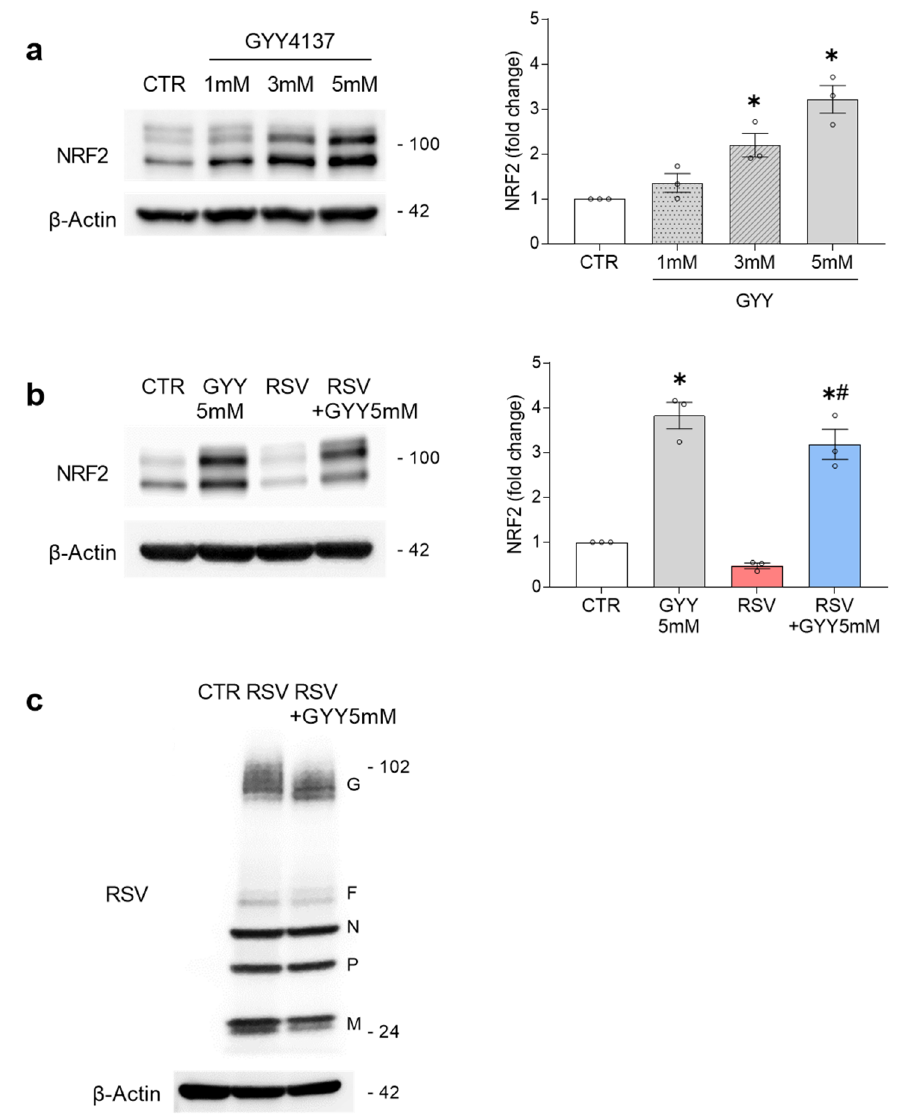
Figure 1. H 2 S donor GYY4137 activates and rescues NRF2 in RSV infection. ( a ) Primary human small airway epithelial cells (SAECs) were treated with 1, 3, or 5 mM GYY4137 or its vehicle. Cells were harvested 17 h after treatment and total cell lysates were analyzed by Western blot with anti-NRF2 antibody. The membrane was reprobed with anti- β -actin antibody for loading control. Western blot image is one representative of three independent experiments. The graph shows the densitometric analysis of NRF2 after normalization to β -actin expressed as mean ± SEM. Data were analyzed by one-way ANOVA followed by Tukey’s test (* p < 0.05 vs. CTR); ( b ) SAECs uninfected and infected with RSV were treated with 5 mM GYY4137 (or vehicle). GYY4137 was added 1 h after RSV infection. Cells were harvested 18 h post-infection (hpi) and total cell lysates were analyzed by Western blot with anti-NRF2 antibody. The membrane was reprobed with anti- β -actin antibody for loading control. Western blot image is one representative of three independent experiments. The graph shows the densitometric analysis of NRF2 after normalization to β -actin expressed as mean ± SEM. Data were analyzed by two-way ANOVA followed by Tukey’s test (* p < 0.05 vs. CTR; # p < 0.05 vs. RSV); ( c ) SAECs were infected with RSV followed by treatment with 5 mM GYY4137. Cells were harvested 18 hpi and RSV proteins were detected in total cell lysates by Western blot using anti-RSV antibody. RSV proteins corresponding bands are indicated on the right. The membrane was reprobed with anti- β -actin for loading control. Western blot image is one representative of two independent experiments.